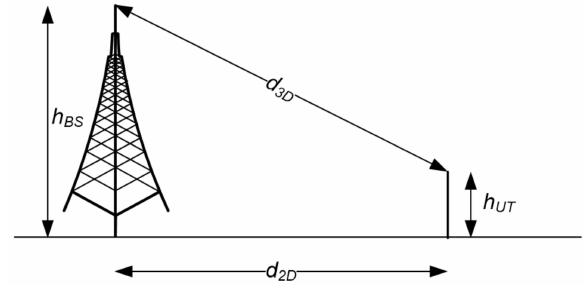
Figure 2. Definition of d 2D and d 3D